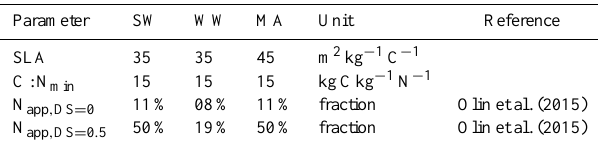
Table A2. CFT-specific parameters of specific leaf area (SLA), min- imum C:N value of the leaves and the amount of the total N that is applied at the different developmental stages (DS), where DS = 0 is sowing and DS = 0.5 is half way into the vegetative phase. The remainder of the total fertiliser application (not listed in the table) is applied at DS = 0.9, which describes the vegetative phase just before flowering; see Olin et al. (2015) for more